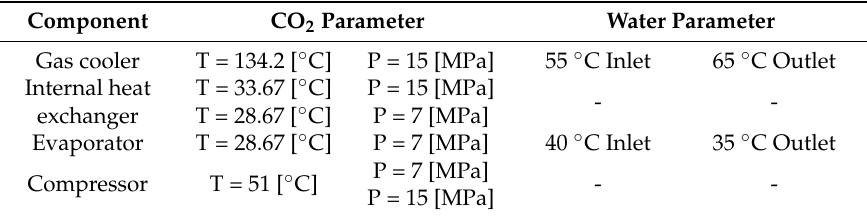
Table 3. Transcritical CO 2 heat pump parameters.